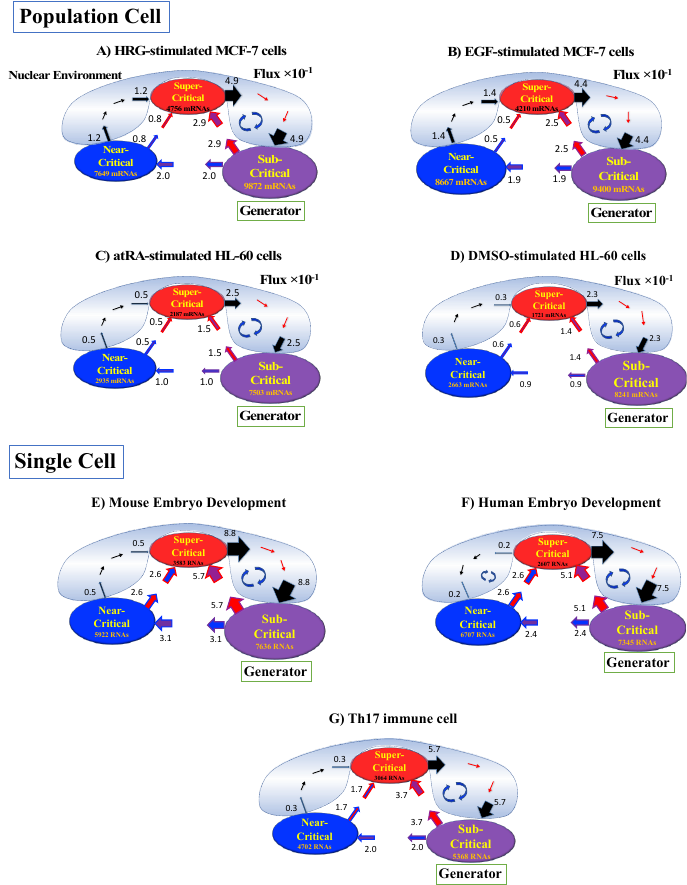
Figure 12. Genome engine mechanism revealed through average between-state expression flux. Cell population: ( A ) HRG-stimulated and ( B ) EGF-stimulated MCF-7 cancer cells; ( C ) atRA-stimulated and ( D ) DMSO-stimulated HL-60 cancer cells. Single-cell: ( E ) mouse and ( F ) human embryo development; ( G ) Th17 immune cell development. Figures show a common genome engine mechanism: sub-super cyclic flux forms a dominant flux flow to establish the genome engine mechanism. The sub-critical state acting as a “large piston” for short moves (low-variance expression) and the super-critical state acting as a “small piston” for large moves (high-variance expression) with an “ignition switch” (a critical point: the genome attractor) are connected through a dominant cyclic state flux as a “camshaft”, resulting in the anti-phase dynamics of two pistons (see the next Figure). Numerical values represent average between-state expression flux, whereas in the cell population, the values are based on a 10 − 1